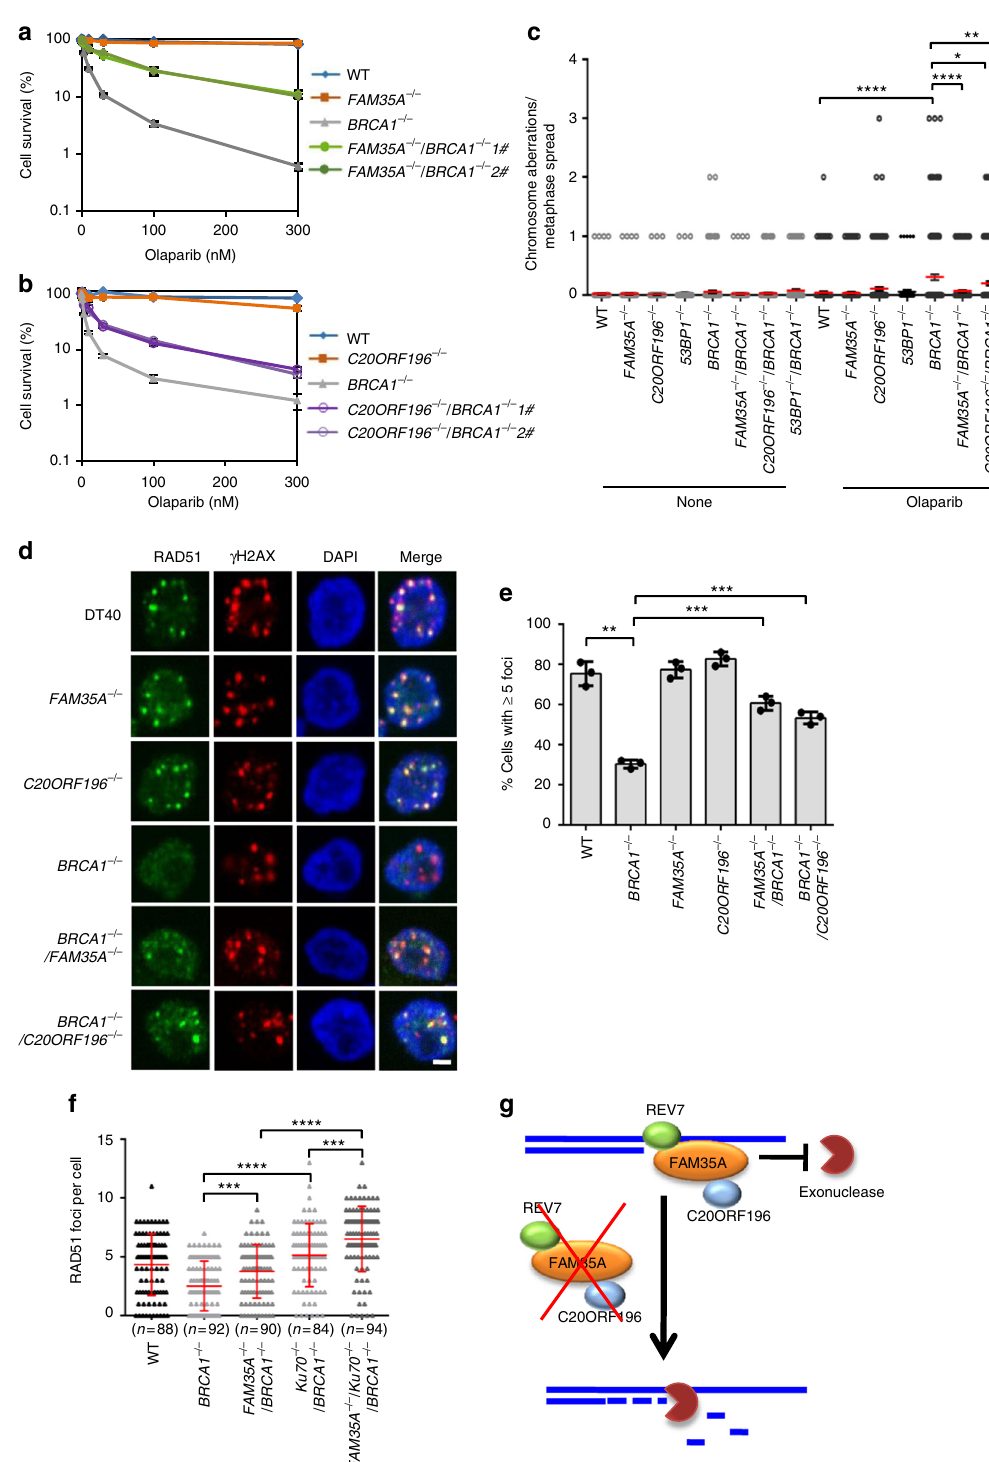
Fig. 5 FAM35A and C20ORF196 block resection in the BRCA1-de fi cient cells. a , b The absence of FAM35A ( a ) or C20ORF196 ( b ) suppressed the olaparib sensitivity of the BRCA1-de fi cient cells. The mean and s.d. from three independent experiments are shown. c Chromosome aberration of various DT40 cells. Cells were treated with or without 1 μ M olaparib for 8 h and then incubated with 100 ng ml – 1 colcemid for 4 h before fi xing. The mean and s.e.m. are shown. d , e Immuno fl uorescence ( d ) and its quanti fi cation ( e ) showing that FAM35A and C20ORF196 block the end resection in the BRCA1-de fi cient cells. The DT40 cells were treated with 4 Gy X-ray and released 4 h before fi xing. The mean and s.d. from three independent experiments are shown. Scale, 2 μ m. f A scatter diagram shows RAD51 foci numbers in DT40 cells after X-ray treatment. The mean and s.d. are shown. g A model shows that Statistics was performed by two-tailed t